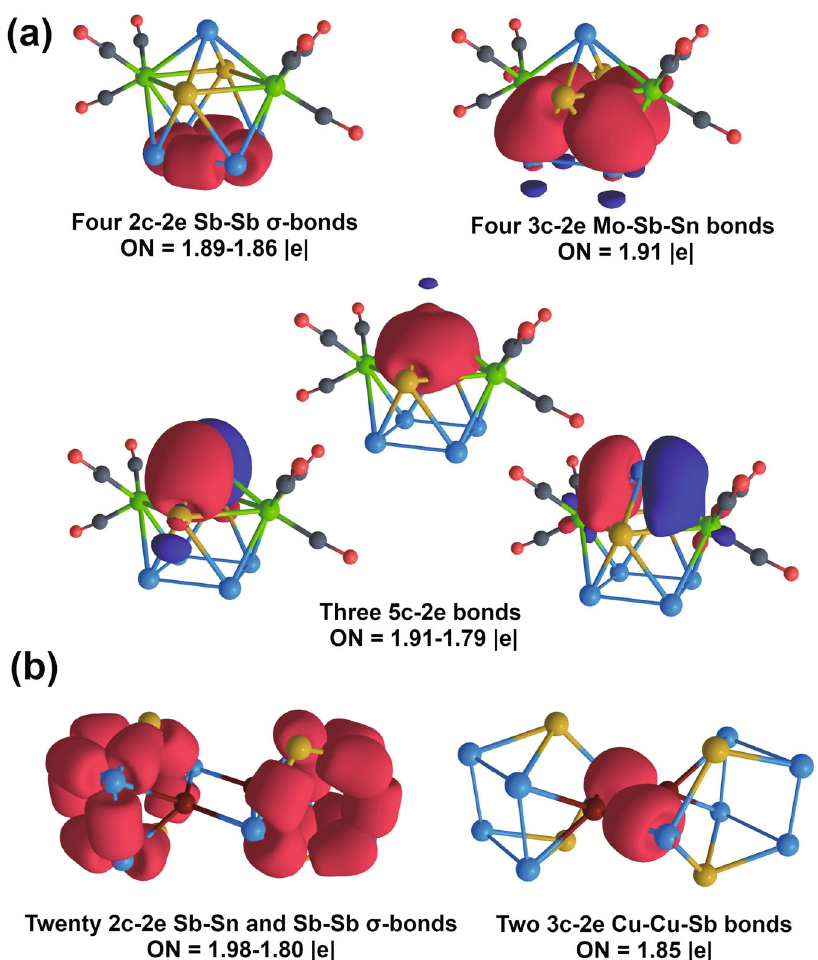
Fig. 4 Chemical bonding pattern of the cage fragments. a [Mo 2 (CO) 6 Sn 2 Sb 5 ] 3 − , b [(CuSn 2 Sb 5 ) 2 ] 4 − . ON denotes occupation numbers (equal to 2.00 |e| in an ideal case). Lines between atoms are presented for visualization and do not necessarily correspond to 2c – 2e bonds. Sn-atoms are dark yellow, Sb- atoms are blue, Mo-atoms are green, C-atoms are gray, Cu-atoms are dark red and O-atoms are